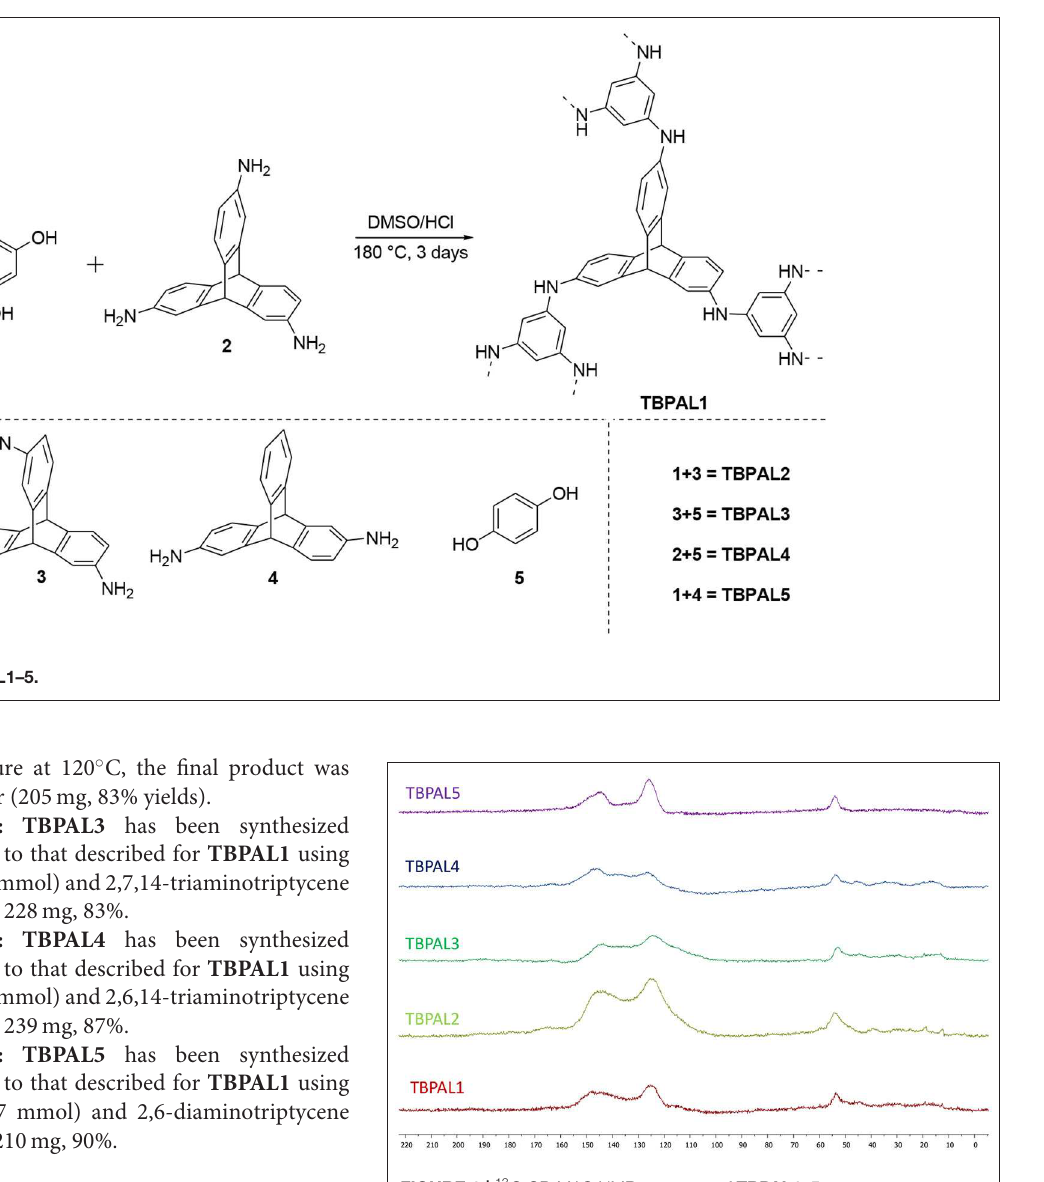
Fourier transform infrared (FTIR) spectral analysis also supported formation of TBPALs ( Figure 2 ). In the FTIR spectra, the bands expected due to the secondary amino group appear in between the range of 3,090 and 3,600 cm − 1 (N–H stretching). The C–N stretching vibration bands were centered at 1,020 cm − 1 . Additionally, the bands due to aromatic C = C stretching for the aromatic rings and the N–H bending appeared in the range 1,500 to 1,700 cm − 1 . The field emission scanning electron microscopy (FESEM) images show amorphous morphology with a large number of pores on the surface of TBPALs , which may be due to cross- linking of amine functional groups in rapid and random manner across the polymer framework ( Figure 3